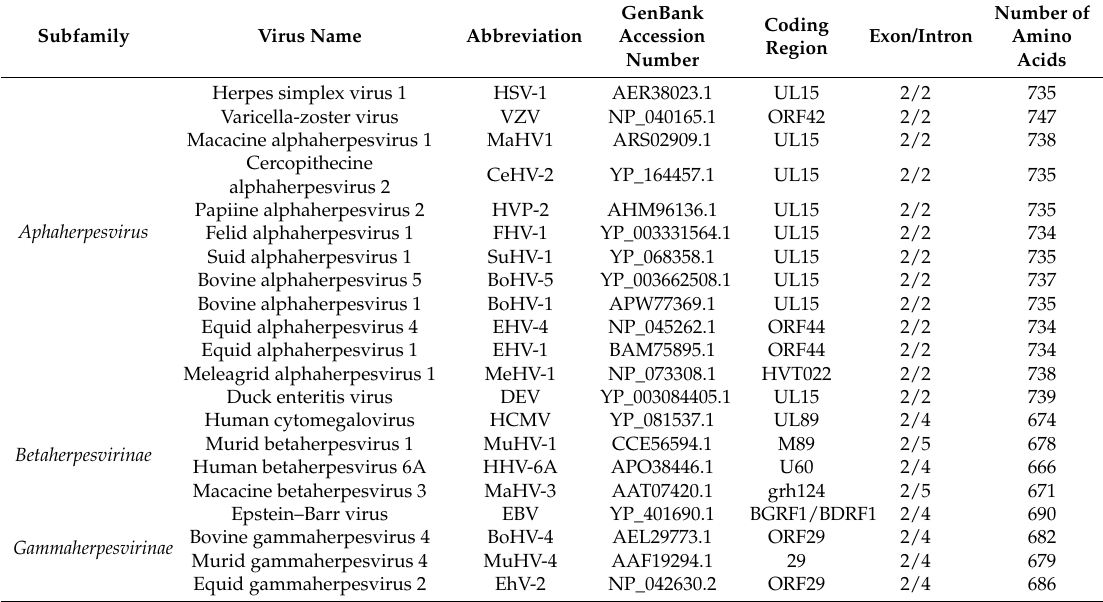
Table 1. Features of herpesvirus UL15 gene and